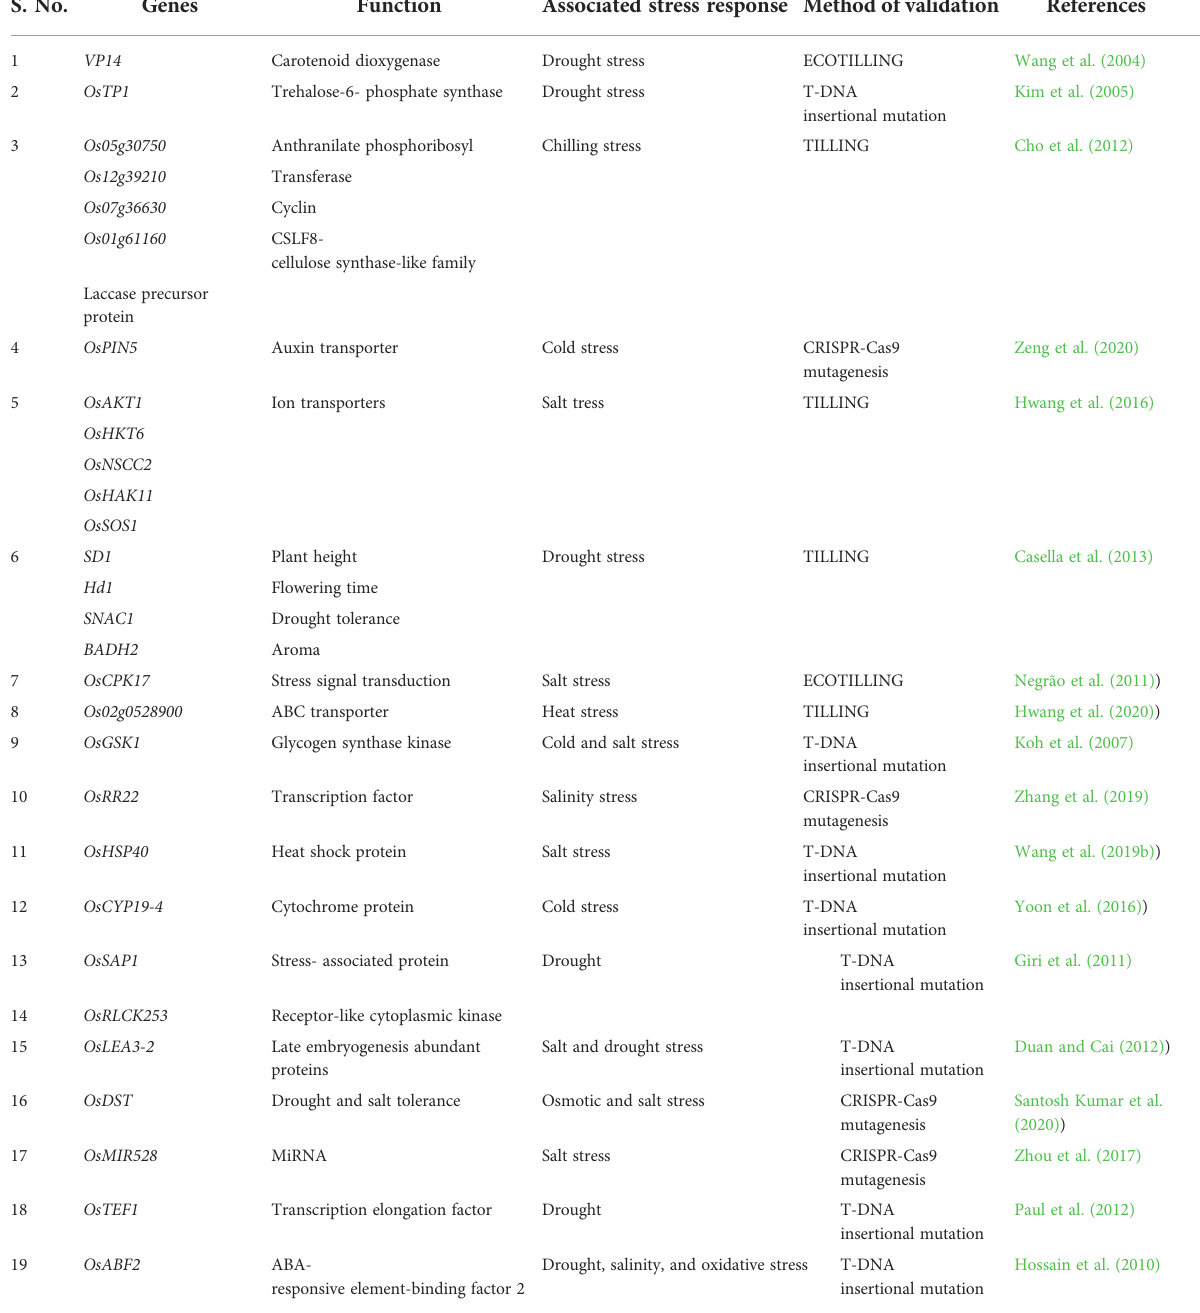
TABLE 1 Summary of abiotic stress-responsive genes in rice identi fi ed using genomic approaches. S.